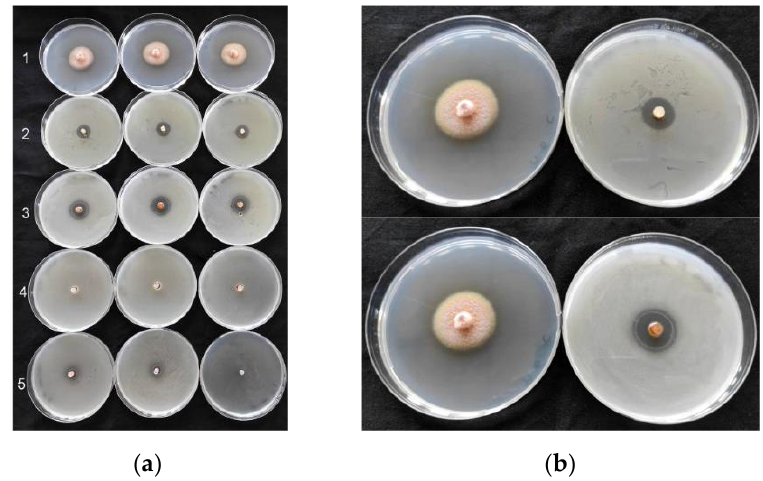
Figure 1. ( a ) Activity of bacterial cells against Plenodomus tracheiphilus isolate PT6: 1, control plates; 2, Bacillus amyloliquefaciens strain D747 (Amylo-X ® ); 3, B. amyloliquefaciens FZB24 (Taegro ® ); 4, B. amyloliquefaciens MBI600 (Serifel ® ); 5, B. amyloliquefaciens QST713 (formerly B. subtilis ; Serenade ® ). ( b ) Detail of inhibition halos around pathogen colonies induced by B. amyloliquefaciens QST713 (formerly B. subtilis ; Serenade ® ) (up) and B. amyloliquefaciens strain D747 (Amylo-X ® )(down).